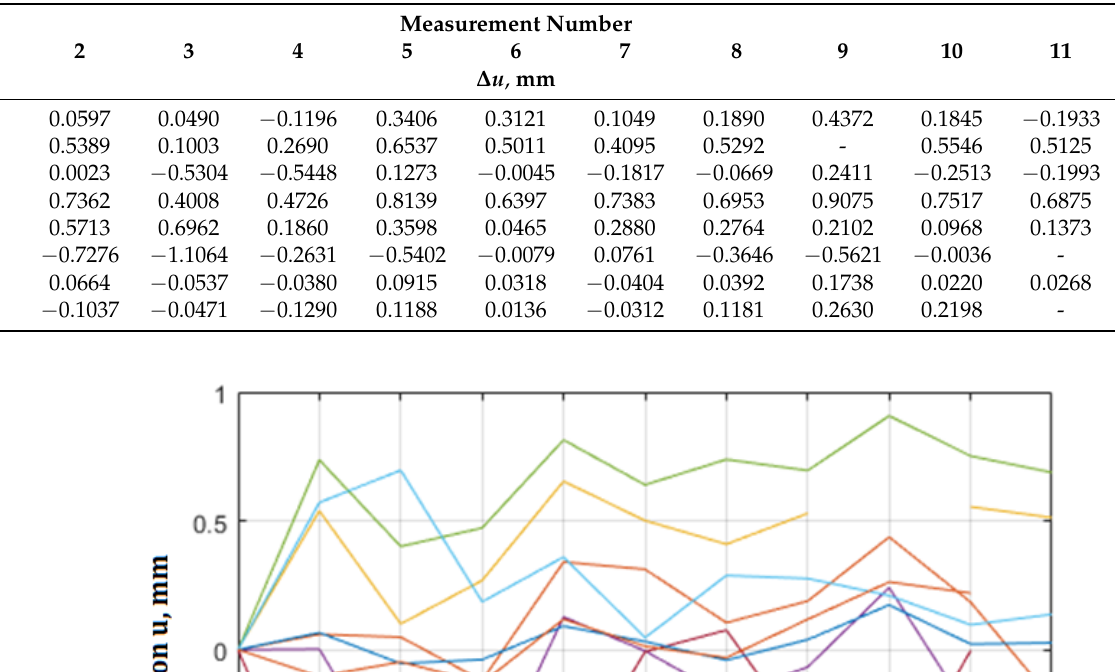
Table 2. Changes in the characteristic dimensions (deformation) of the gondola in successive mea- surements.